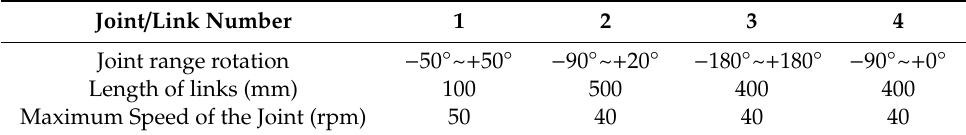
Figure 11 : Robot legs ’ arrangement schematic. Figure 11. Robot legs’ arrangement schematic. Table 5. Specifications of UMSWR links and